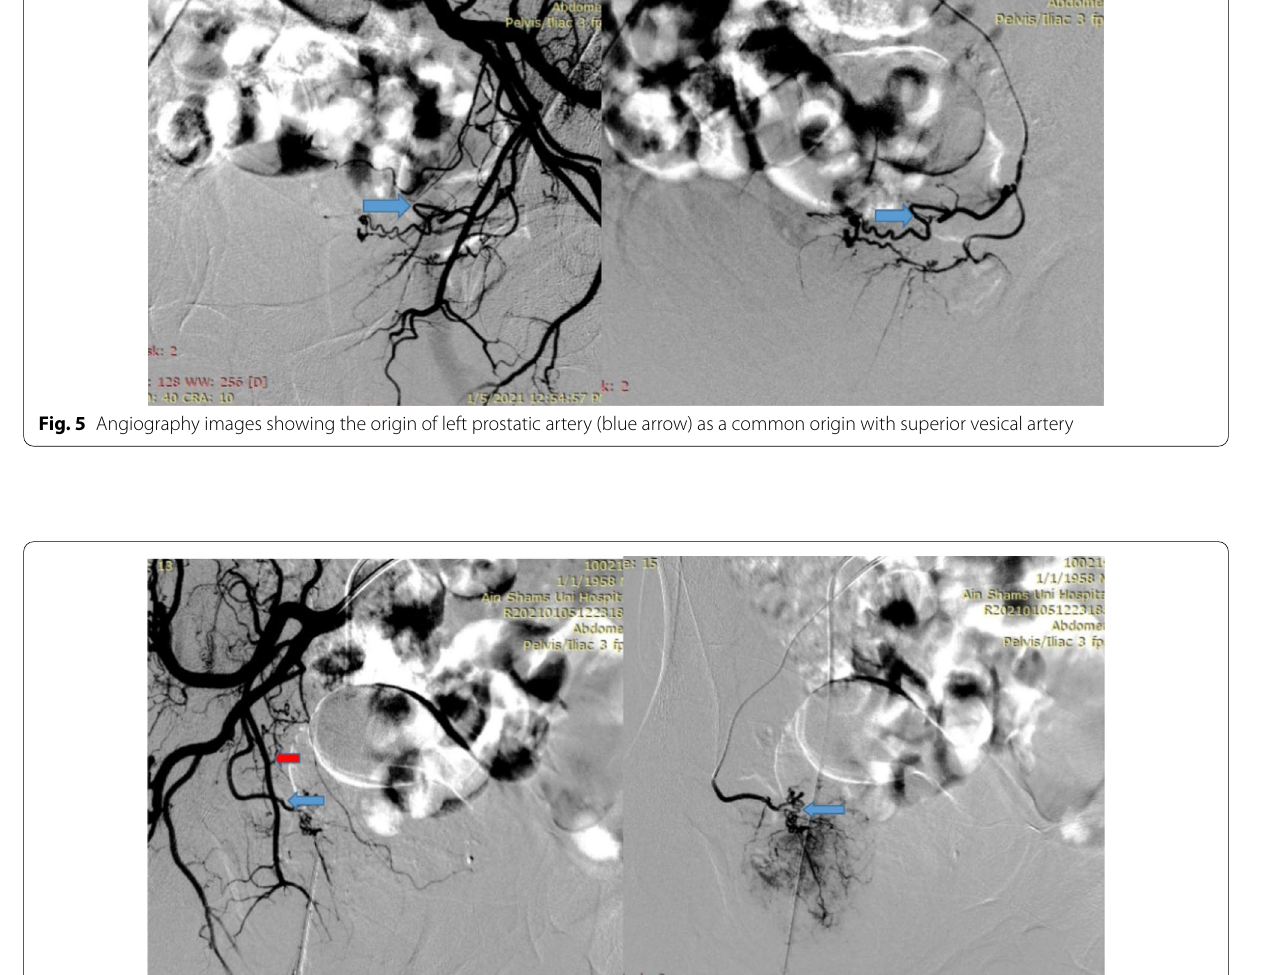
between both pelvic right and left sides was demon- strated in this case (Fig. 13). And here is a last case of a patient with right-side pros- tatic artery arising below superior vesical artery (type II) (Fig. 14) and left side prostatic artery arising from puden-